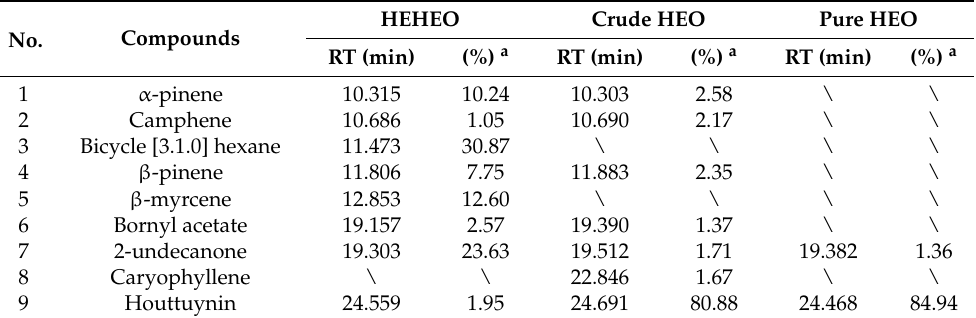
Table 3. GC analysis of HEHEO, crude HEO and pure HEO with peak identification and area percentage. HEHEO Crude HEO No. Compounds